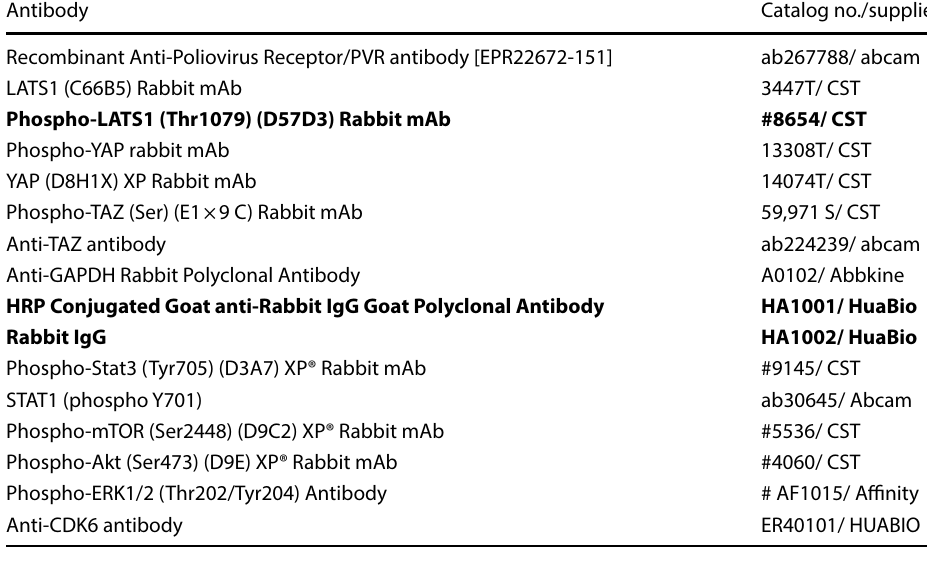
Data was evaluated using the Bliss independence